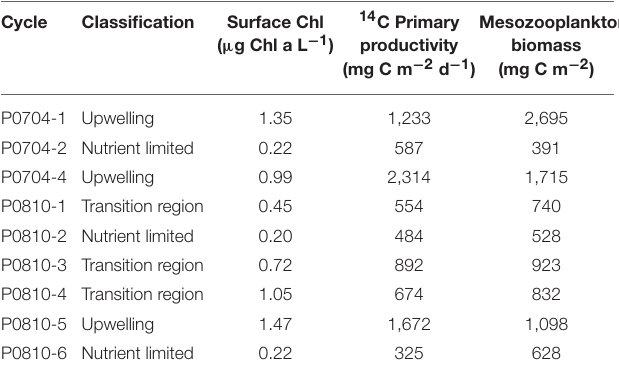
TABLE 1 | Overview of conditions for each cycle along with the attributed classifications: upwelling, transition region, and nutrient limited. Cycle